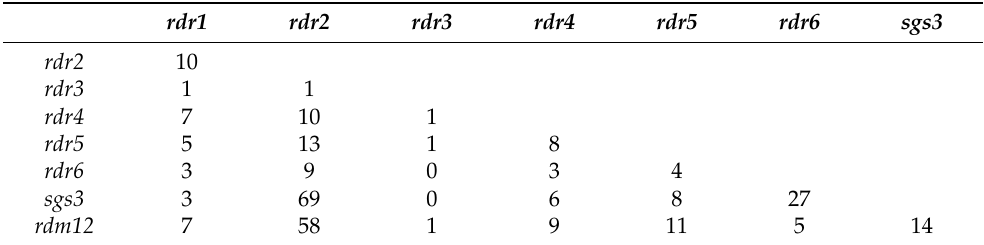
Table 2. Shared putative substrates among RDRs, RDM12, and SGS3. Shared substrates are counted by overlapping the union of sense and antisense differentially abundant putative substrates found in Table 1. rdr1 rdr2 rdr3